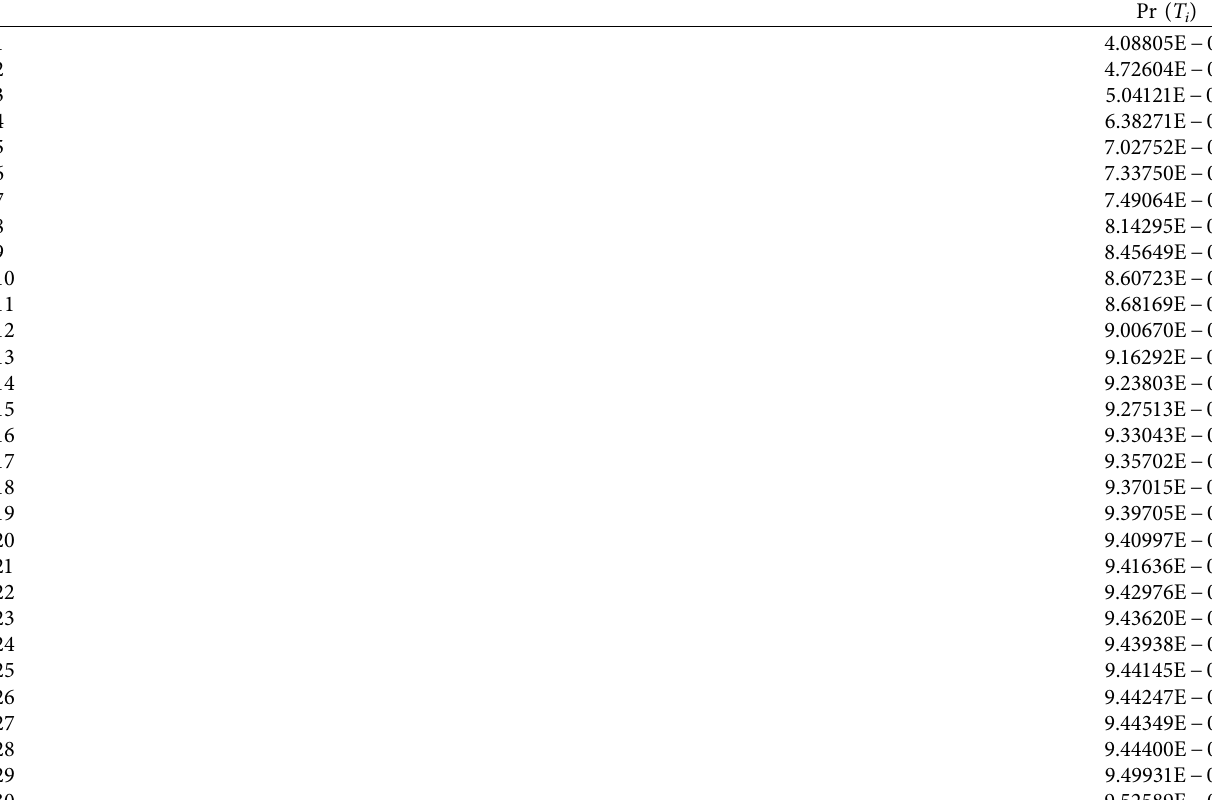
Table 16: The Deg ( i ), N